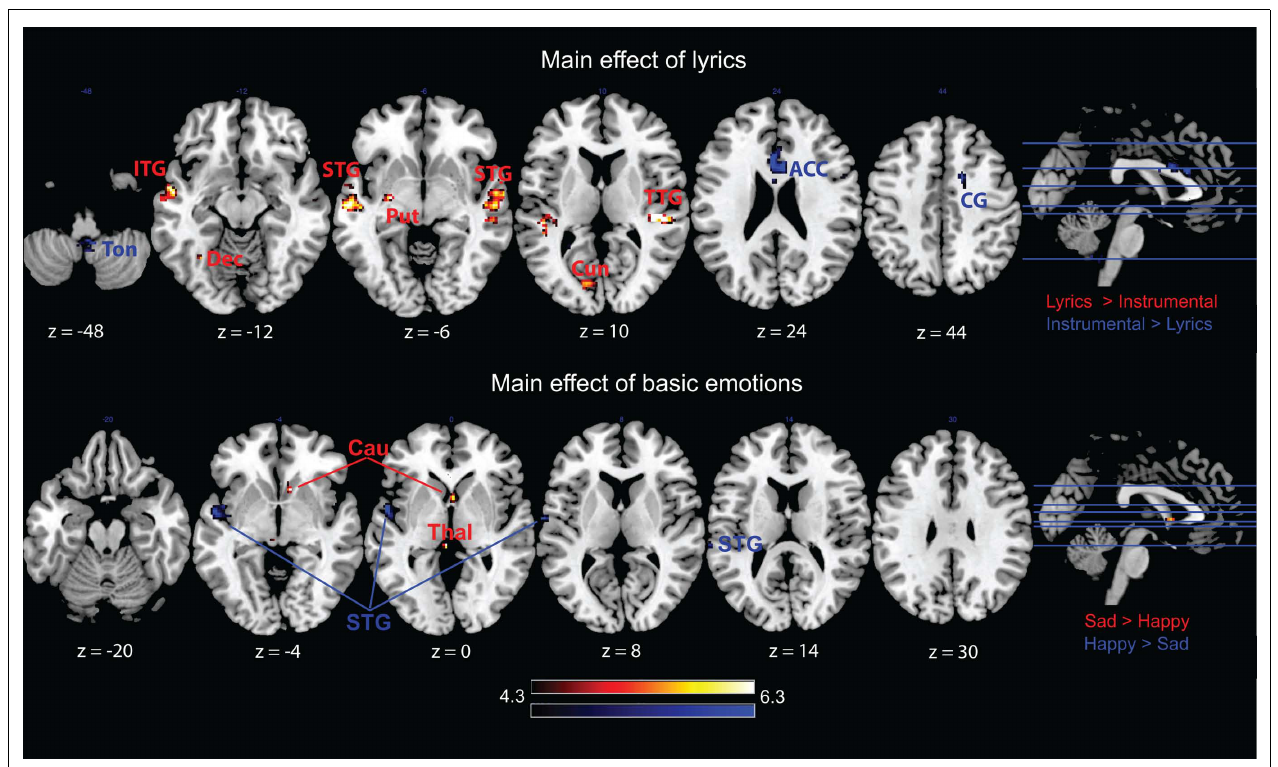
for inferior temporal gyrus, Put for putamen, STG for superior temporal gyrus, TTG for transverse temporal gyrus, andThal for thalamus. Activations were considered significant at p < 0.001, Z > 3.5, and k >